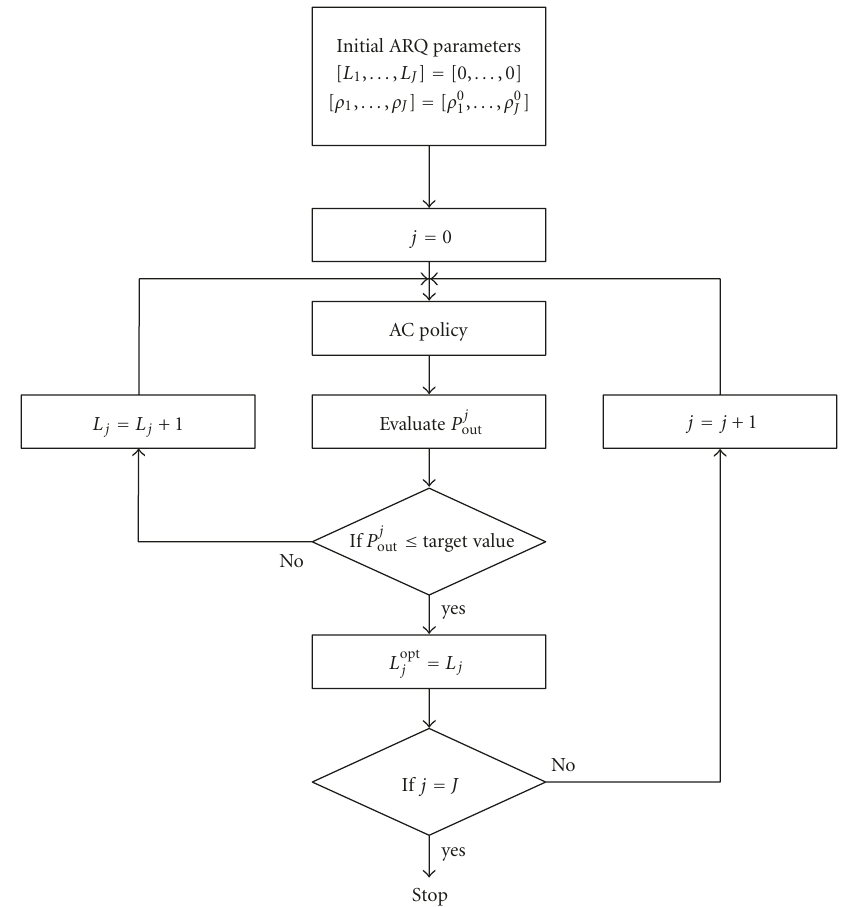
Figure 1: Search procedure of the optimal number of